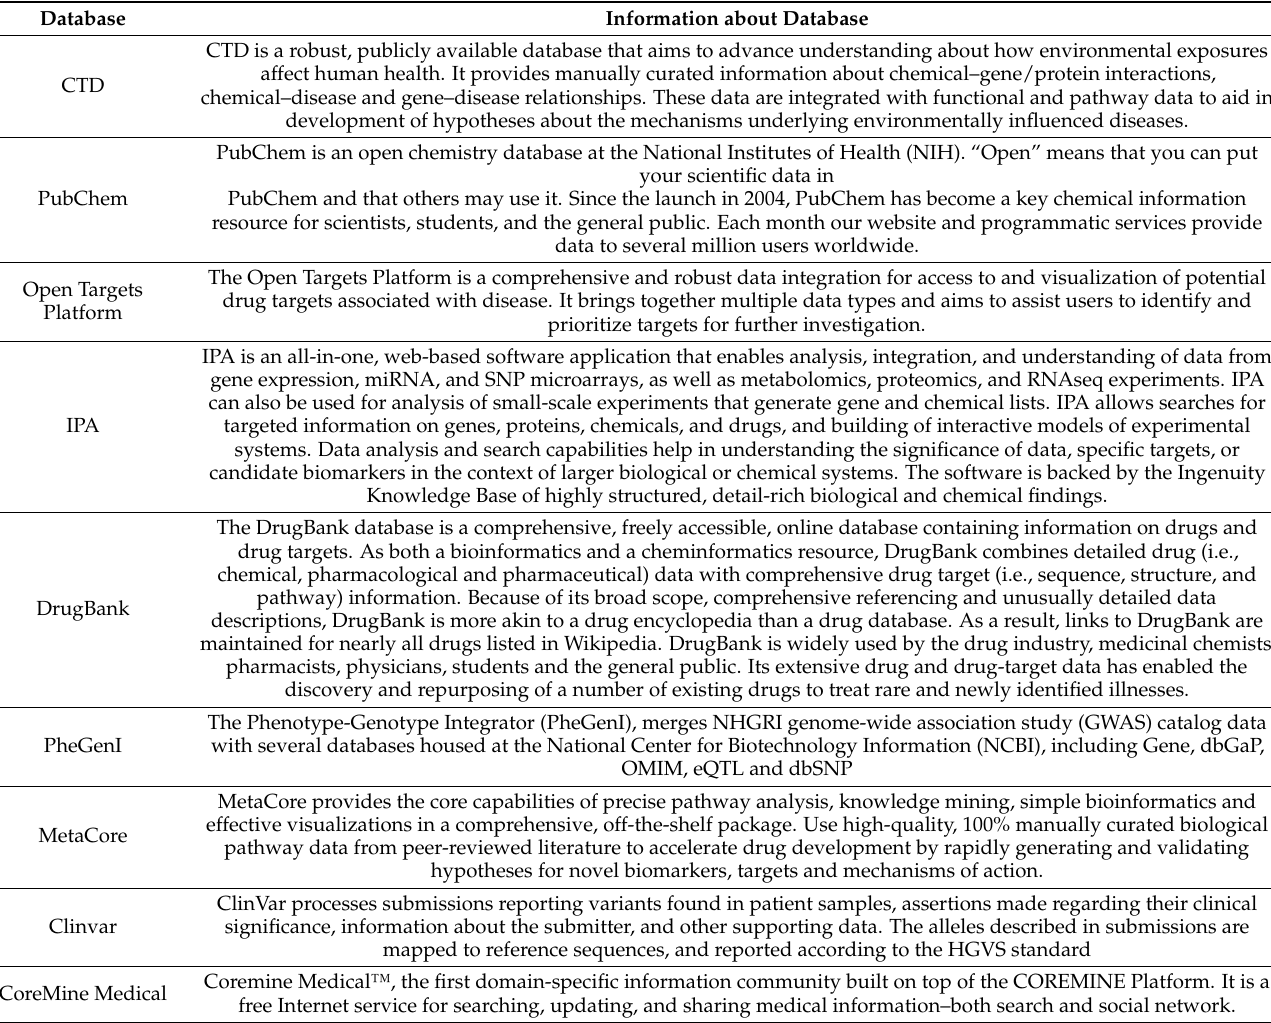
Table A1. Table describing each database used for network topological analysis work. Information taken from the about page of each database’s